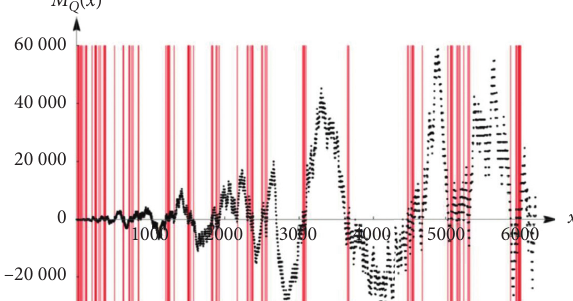
Figure 6: M ( n ) for n from 1 to 6000 with its first 101 “gener- Q ations” separated by vertical